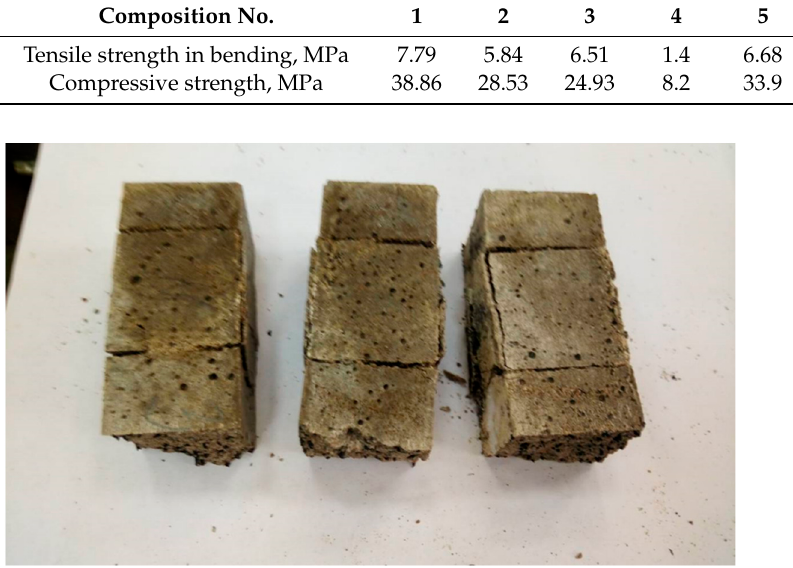
Figure 8. The character of destruction of samples with composition No.5 (crumpling the concrete).